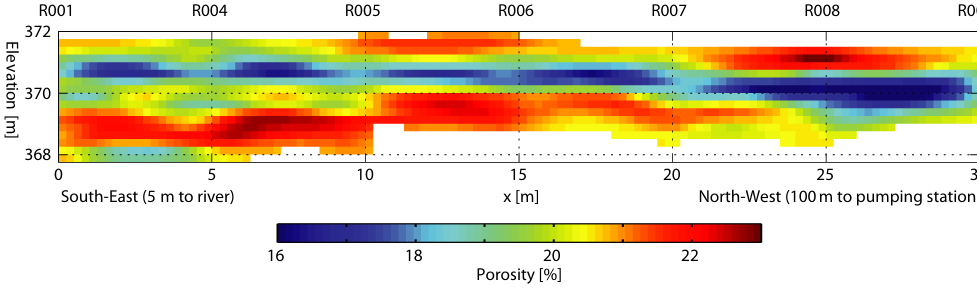
Fig. 9. Porosity distribution along the pumping-station transect (transect A in Fig. 2) obtained by cross-borehole georadar travel-time tomography. A continuous low-porosity layer is imaged across the entire profile between two higher-porosity subhorizontal layers. Note that the porosities represent average porosities on the m-scale and that the absolute values might be slightly down or upward biased given the uncertainty of the parameter values chosen for the petrophysical